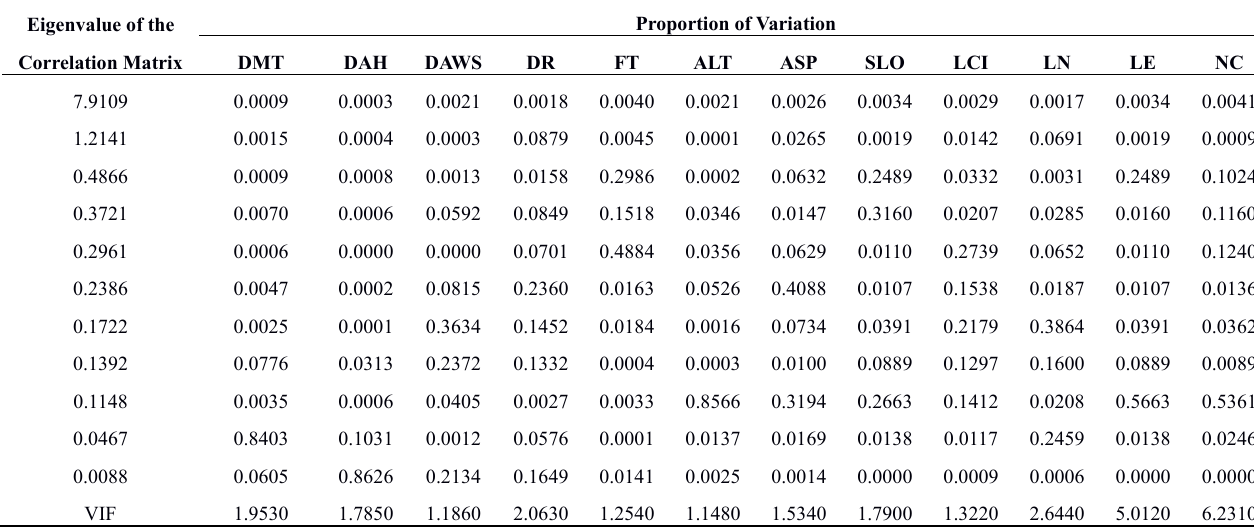
Table 4. Multi-collinearity diagnostics for environmental candidate